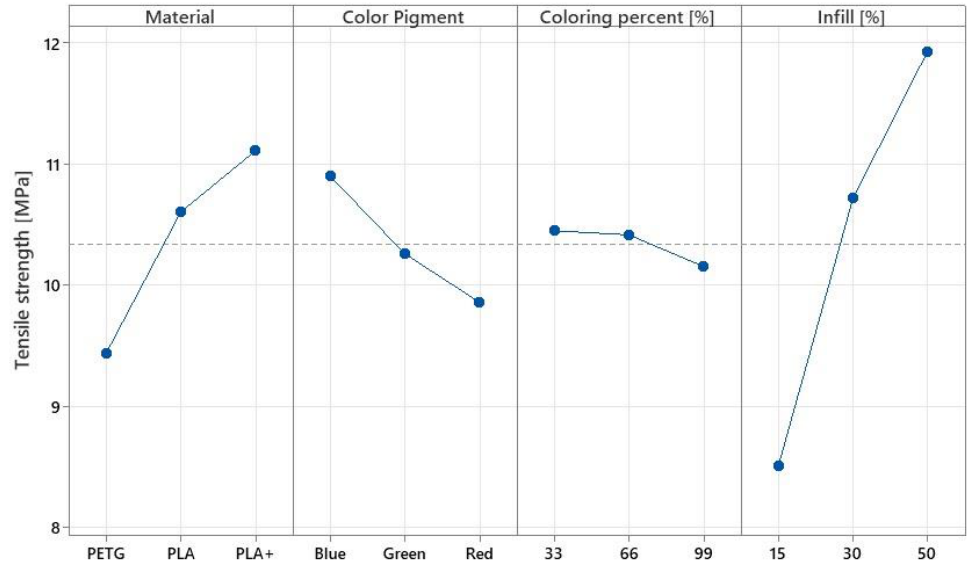
Figure 13. Variation of the main effects for tensile tests.